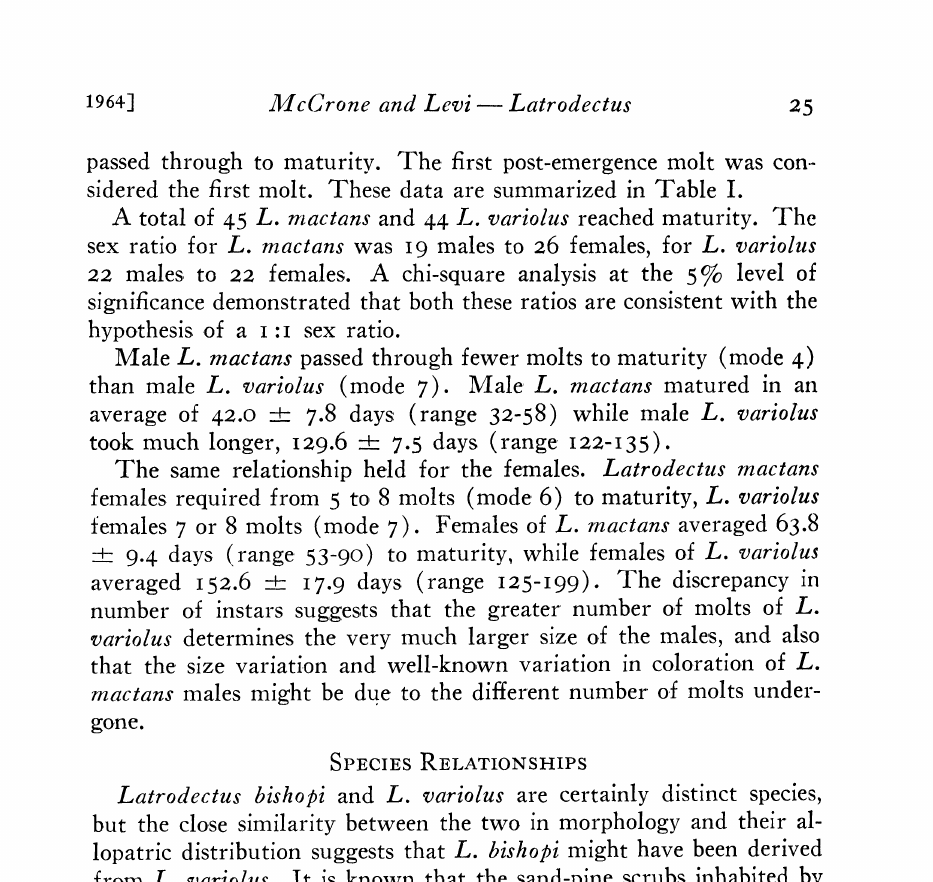
Fig. 26. Latrodectus mactans (Fabricius) female from Tennessee. Fig. 27. Latrodectus eariolus Walckenaer, female from northern Florida. (Photograph by H. K. Wallace) Fi. 28. Habitat of L. ariolus in lower limbs of trees in northwestern